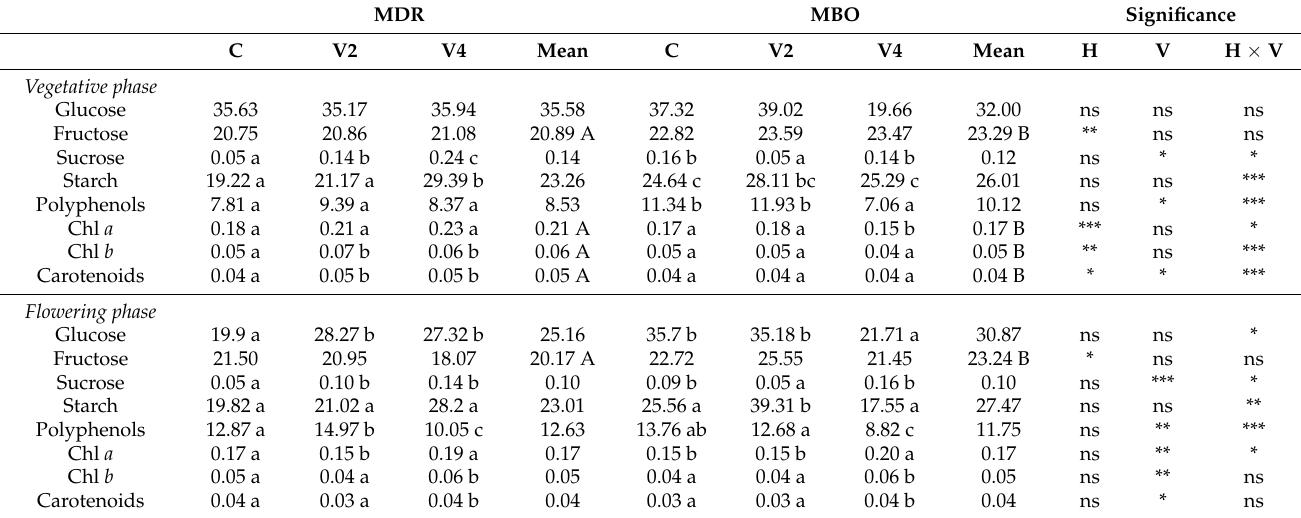
Table 3. Glucose, fructose, sucrose and starch (in mg g − 1 DW), chlorophyll a (Chl a ), chlorophyll b (Chl b ), carotenoids, and polyphenols (in µ g g − 1 DW) in plants of Ranunculus asiaticus L. hybrids MDR and MBO, obtained by three vernalization procedures of tuberous roots, only rehydration (Control, C), rehydration plus vernalization for 2 weeks (V2), rehydration plus vernalization